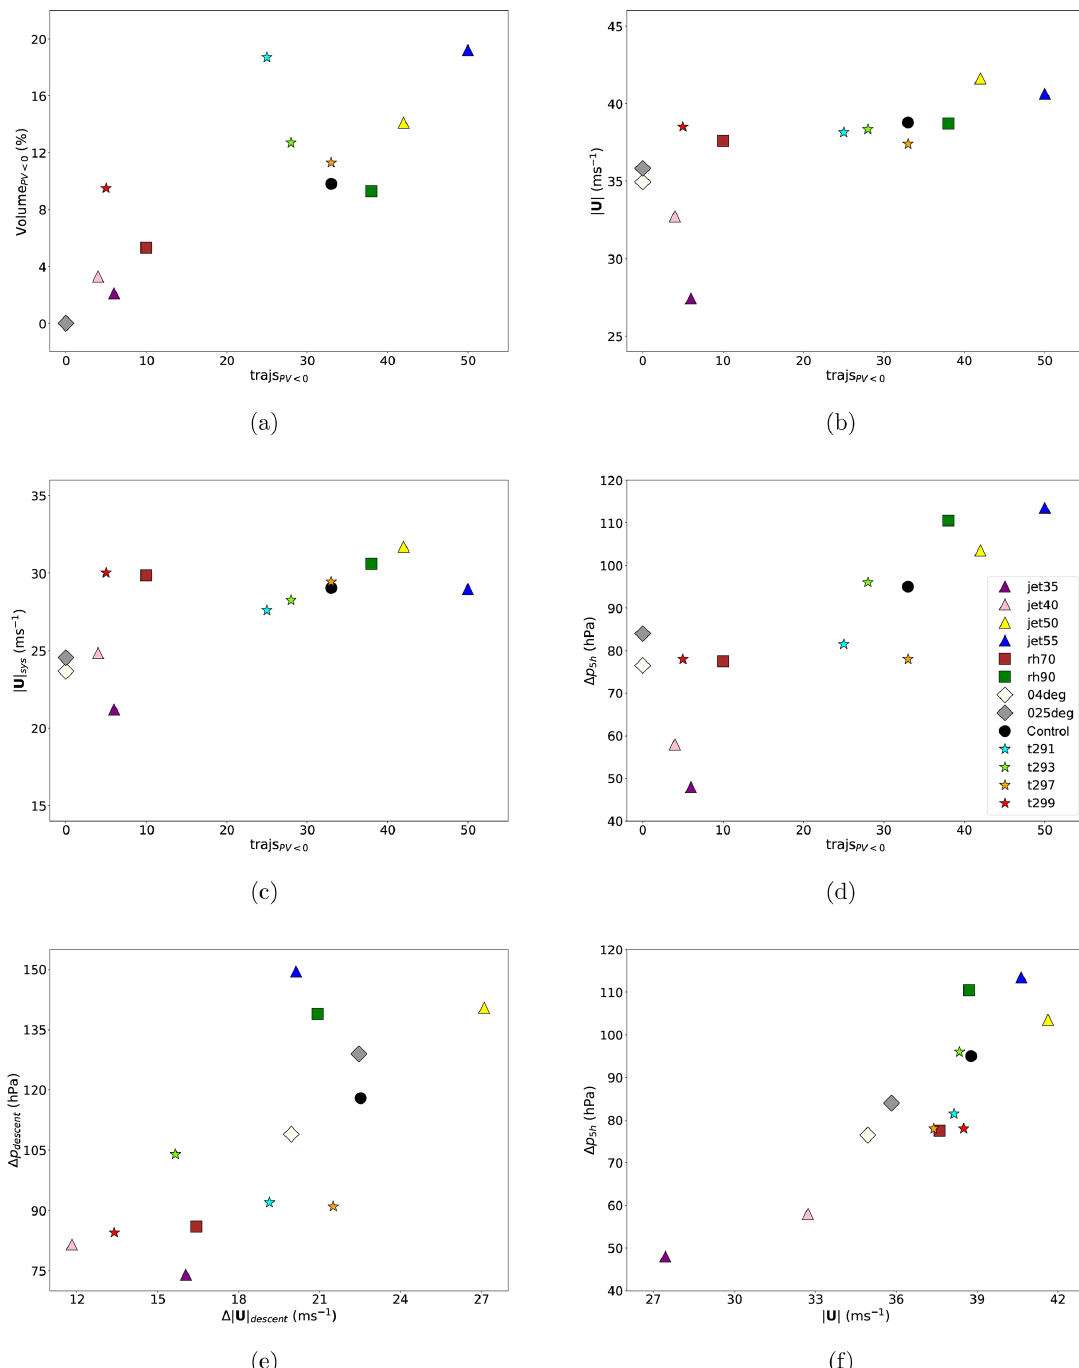
Figure 12. Scatterplots showing, for all the sensitivity experiments, (a) volume PV < 0 against trajs PV < 0 , (b) | U | against trajs PV < 0 , (c) | U | sys against trajs PV < 0 , (d) (cid:49)p 5h against trajs PV < 0 , (e) (cid:49)p descent against (cid:49) | U | descent and (f) (cid:49)p 5h against | U | . trajs PV < 0 is the maximum number of trajectories of the 100 selected with negative PV at any instant within 15h from the time when the trajectories are selected (i.e. identification time), and volume PV < 0 indicates the maximum percentage of grid points with negative PV, evaluated in the same time window as trajs PV < 0 , in a volume centred on the location of the median of trajectories and extending for 20 grid points in latitude, 40 grid points in longitude and three vertical pressure levels (note that the symbols for the reduced resolution simulations overlie at point (0,0) in panel a ). | U | is the maximum Earth-relative speed, | U | sys is the system-relative speed at the time when | U | is reached, and (cid:49)p 5h is the maximum 5h pressure increase in a period ending by identification time. (cid:49)p descent and (cid:49) | U | descent indicate, respectively, total pressure increase and speed increment during the whole SJ descent, whose end is taken at identification time and whose start has to be not more than 12h before. All these kinematic quantities refer to the median of